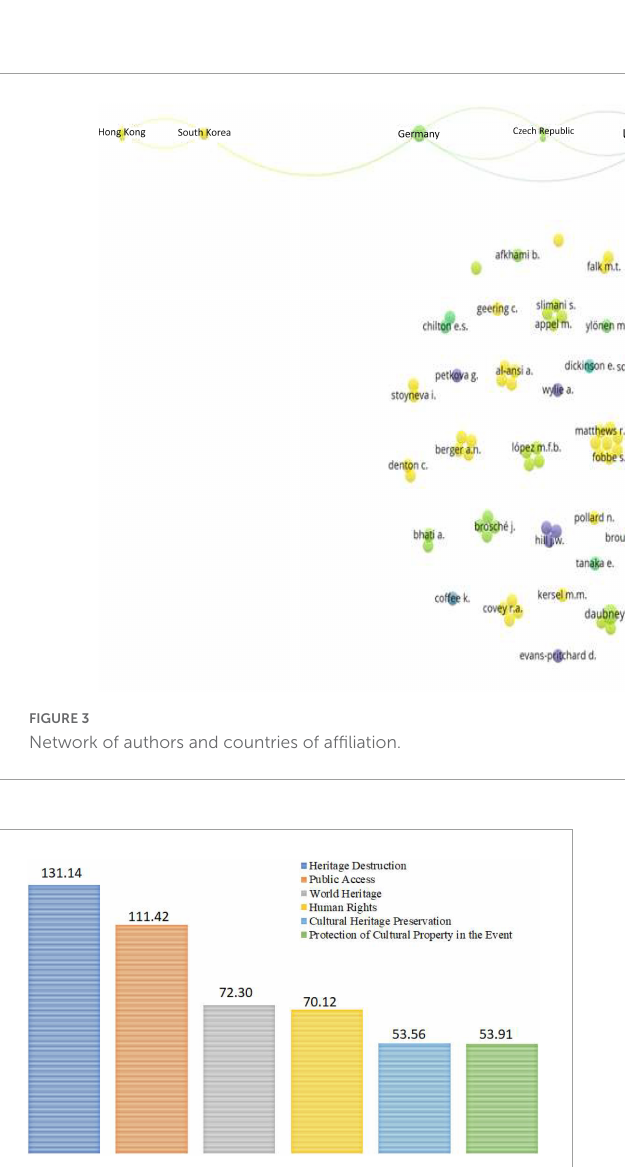
FIGURE4 Text clustering. Only clusters with scores higher than 50 that represent concepts were considered. Score: shows the relevance value assigned to the